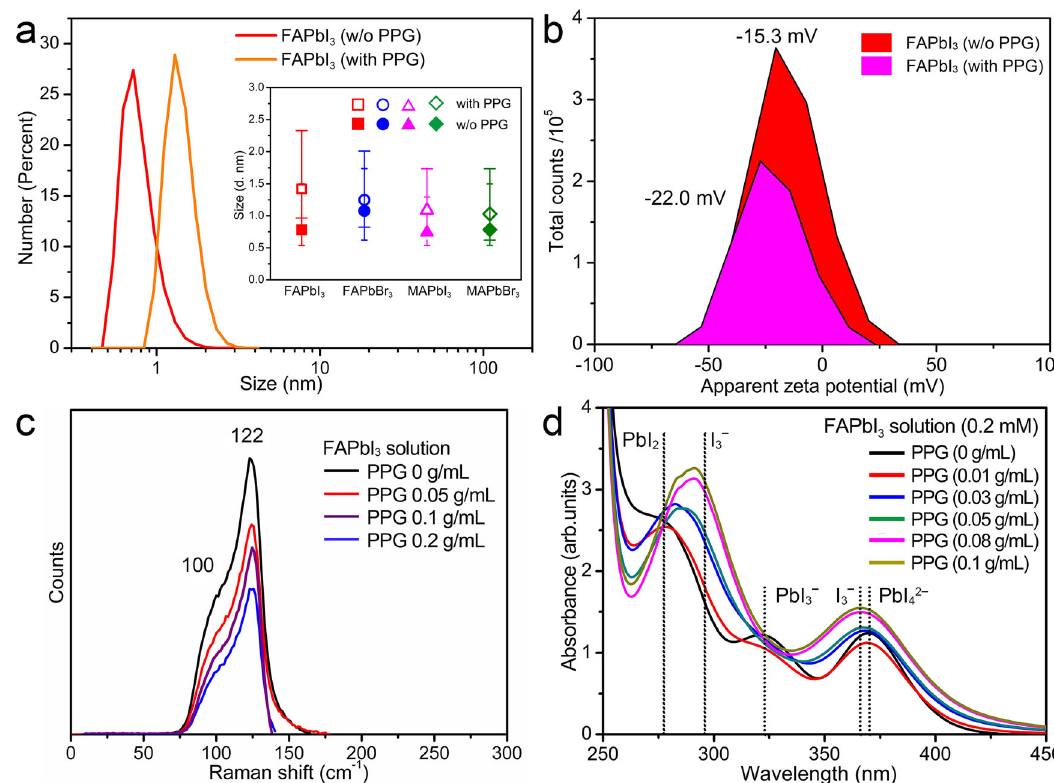
Fig. 3 The effects of PPG-3000 addition on the growth solutions. a The size distribution of colloid in precursor solutions with or without PPG-3000, measured by dynamic light scattering. The error bars of inset ( a ) indicate the colloid size range, note that the solution of PPG-3000/GBL without OIHPs does not present signals. b The zeta potential ( ζ ) of the colloidal particles in the FAPbI 3 ( C FAPbI3 = 0.094 g/mL) and FAPbI 3 /(GBL + PPG-3000) solutions. ( C FAPbI3 = 0.094 g/mL, C PPG-3000 = 0.006g/mL). c Raman spectra of FAPbI 3 GBL solution (0.75 g/mL) with different concentrations of PPG-3000. d The UV – Vis spectra of FAPbI 3 solution ( C FAPbI3 = 0.2 mM) with different concentrations of